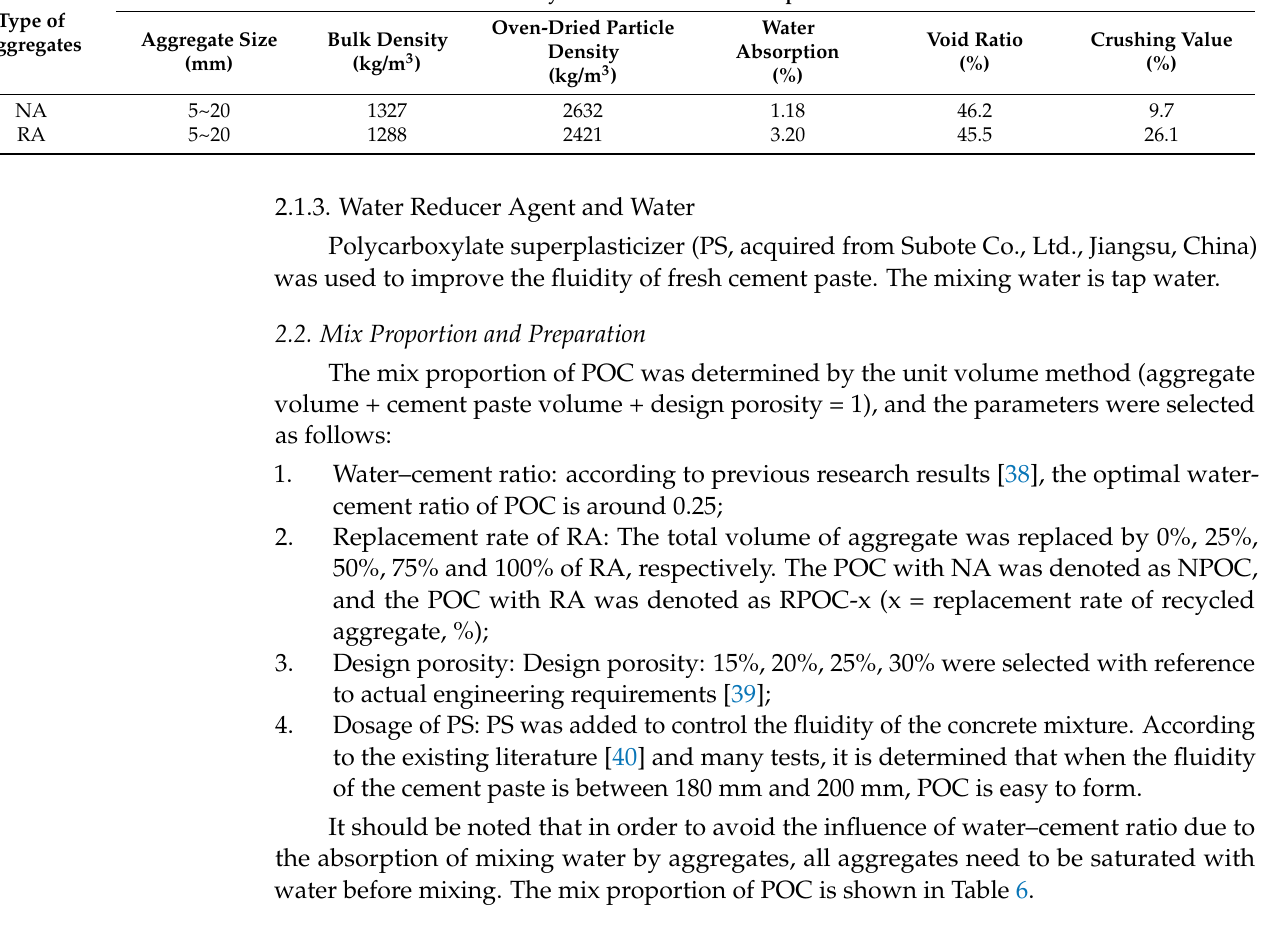
Table 6. Mix proportion of porous